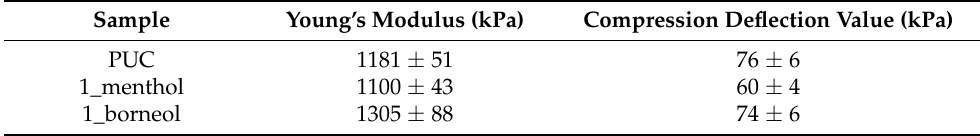
Table 5. Mechanical properties of selected